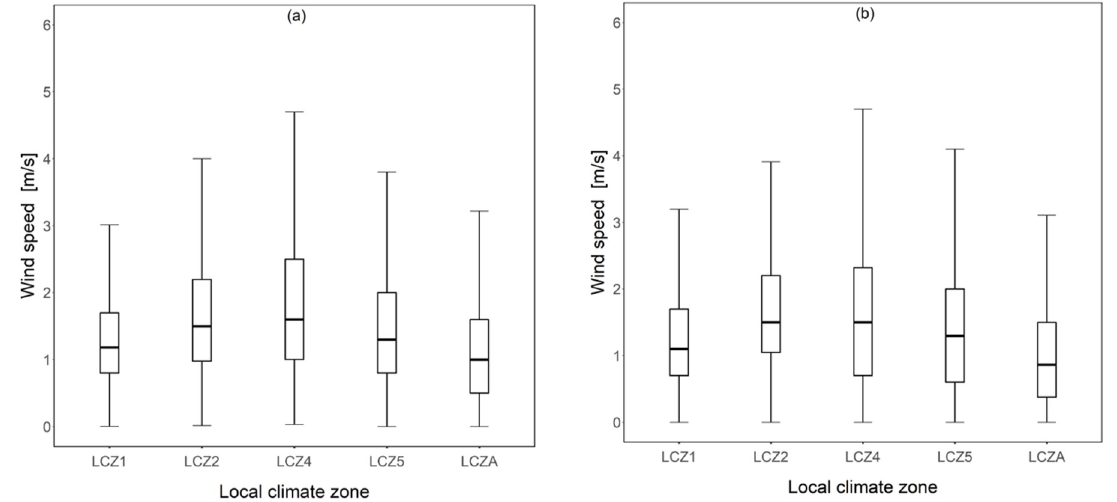
Fig 9. Wind speed distributions across different LCZs. (a) 2012 (b)